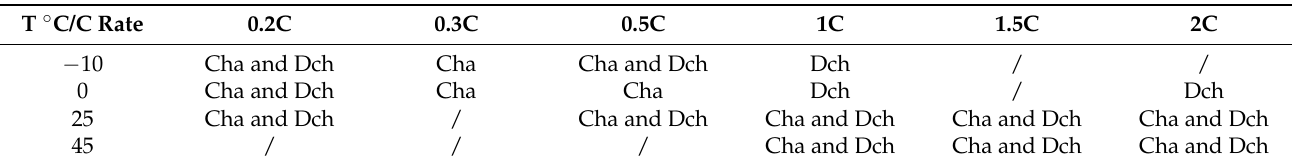
Figure 1. Large-size battery thermoelectric coupling layout diagram. Table 1. Capacity test